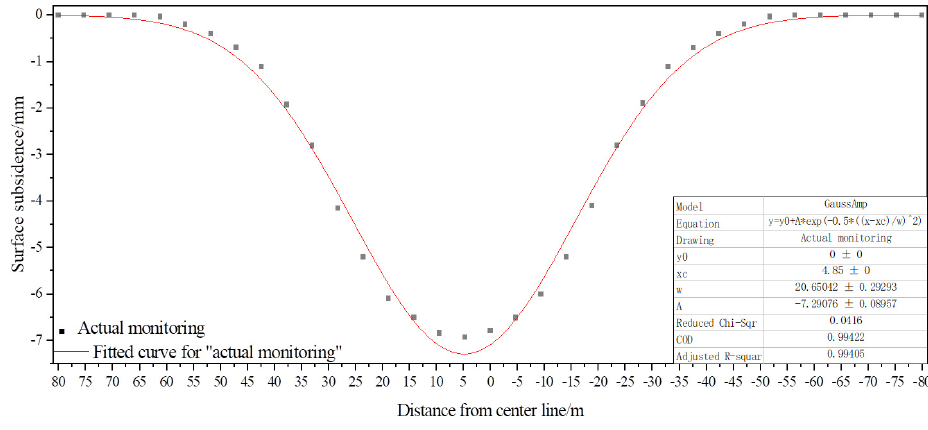
Figure 15. Settlement curve